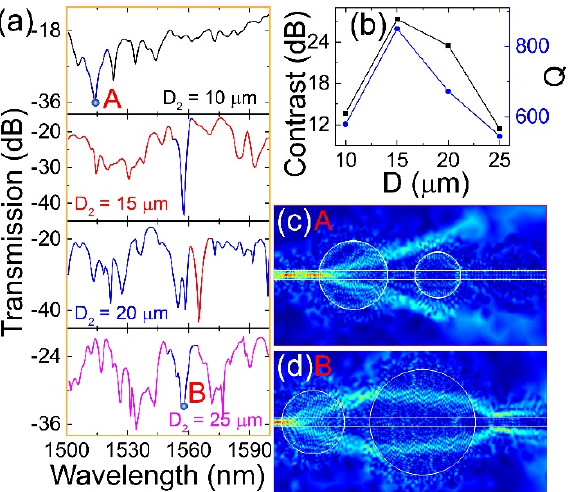
Figure 4. ( a ) The transmission spectra of silica taper-assisted two microspheres with D 1 = 15 µm and gap = 6 µm under different D 2 . ( b ) The corresponding comparisons of the contrast and quality factor under different D 2 . ( c , d ) Electric field distributions at point A and point B in Figure 4a.